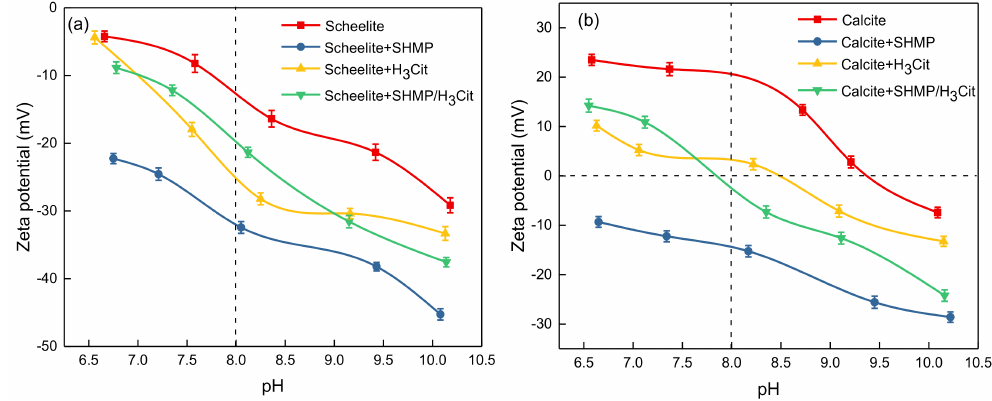
Figure 10. Zeta potential of minerals with di ff erent reagents. ( a ) scheelite, ( b )